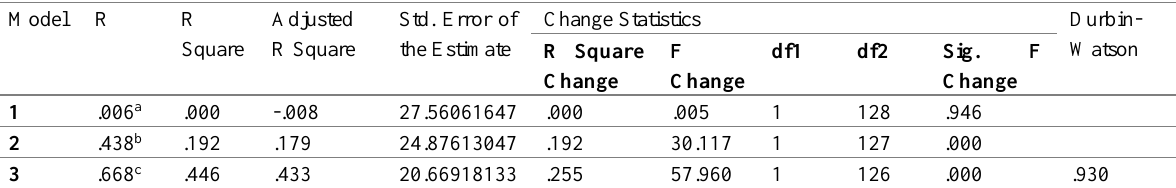
Table: 5: Model Summary